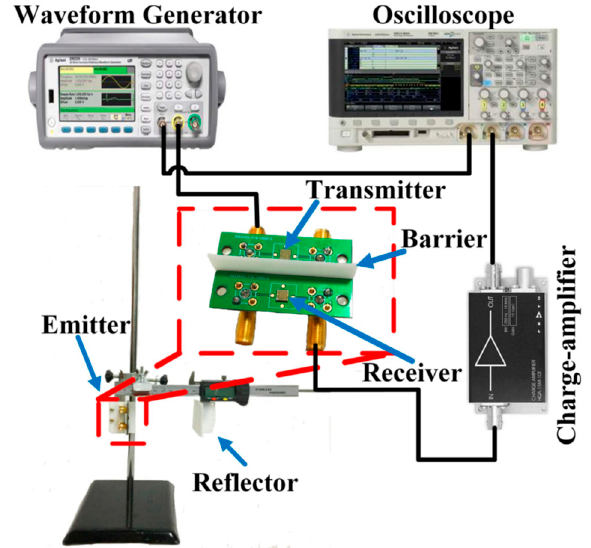
Figure 18. Block diagram of a MFCW pMUT rangefinder system. Reproduced with permission from [35], Copyright 2019, IEEE.